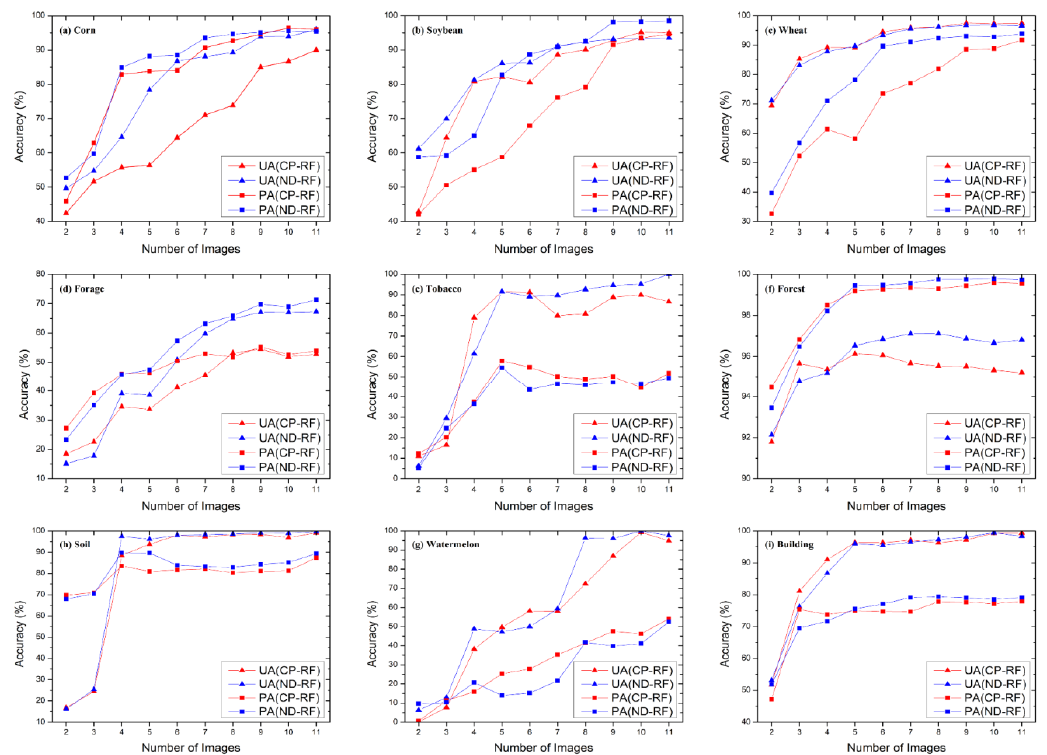
Figure 7. The user’s accuracies or producer’s accuracies of ND-RF and CP-RF classification methods for different land-cover types using different combinations of multi-temporal RADARSAT-2 images. ( a ) Corn, ( b ) soybean, ( c ) wheat, ( d ) forage, ( e ) tobacco, ( f ) forest, ( h ) soil, ( g ) watermelon and ( i ) building.